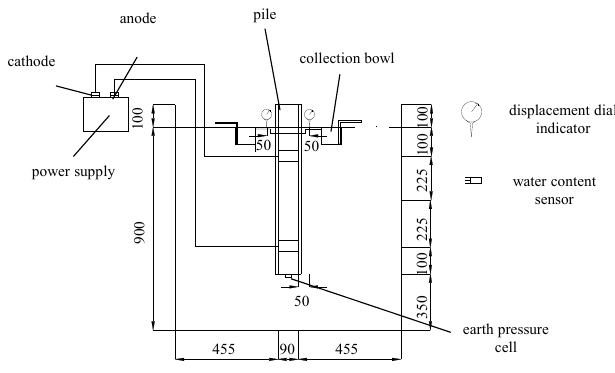
Figure 2. Layout of electro-osmosis test from bottom to top.